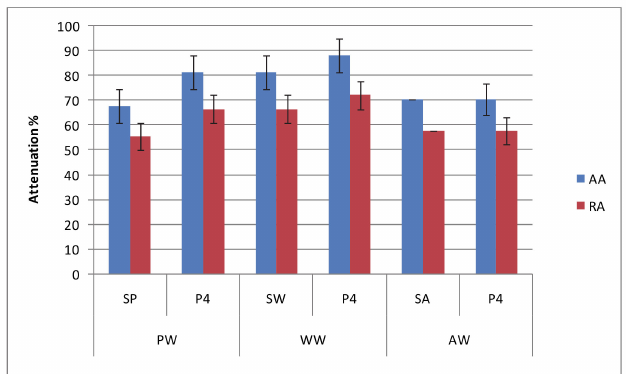
Figure 1. The apparent (AA) and real (RA) degree of attenuation (%) of the beers obtained by P4 and the three commercial starters (Pilsen starter (SP), Weizen starter (SW) and Amber starter (SA)) in wort obtained from malt extract for Pilsen (PW), Weizen (WW) and Amber (AW) beers. Data are the mean of two independent